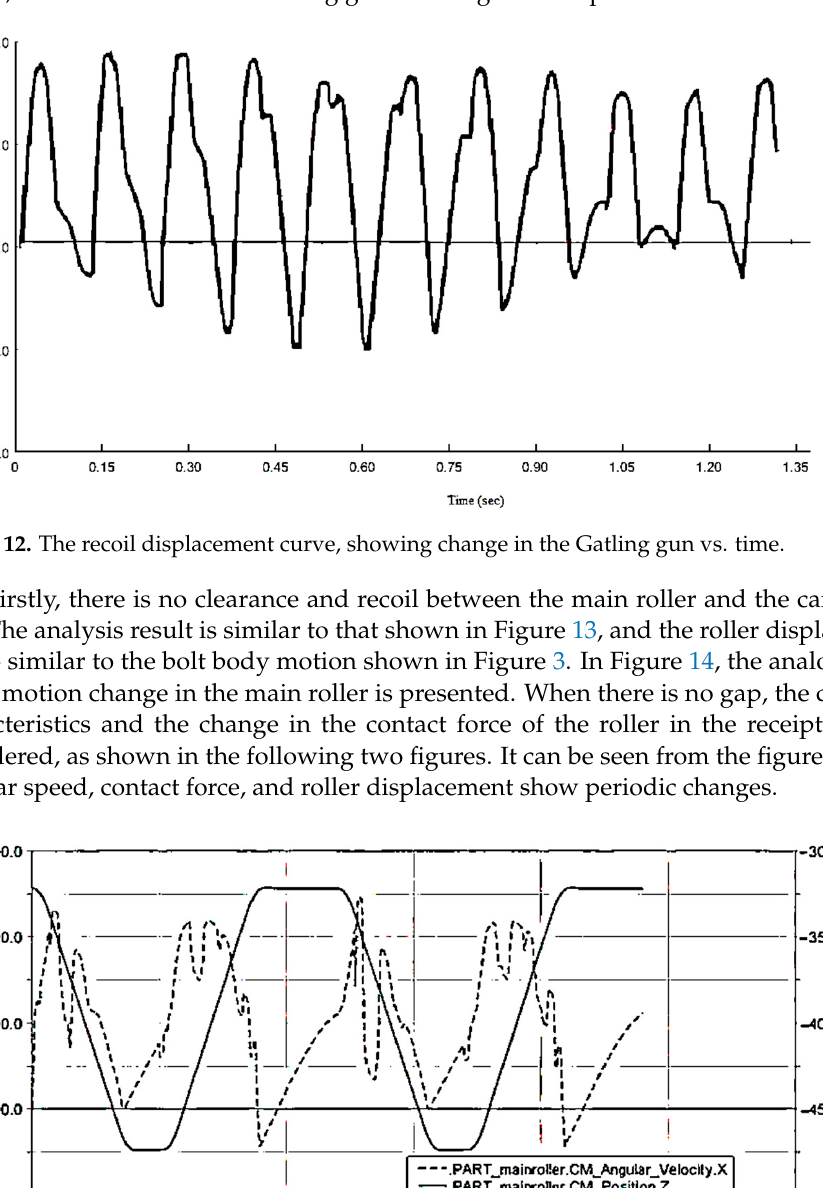
Figure 14. The motion change curve in the main roller with the consideration of gap and no recoil. The dynamic characteristics of the main roller of the gap secondary cam mechanism are shown in Figures 13 and 14: the red dashed line represents the angular speed of the main roller, the solid black line represents the position of the main roller, the blue dotted line represents the change in the contact force of the main roller and the rear end of the curve groove, and the black dotted line represents the contact force of the change in the front end of the main roller. It can be seen that, because of the existence of the gap, the main roller and the two ends occur. After the firing rate is stabilized, the automaton gradually tends towards the periodic movement. During an average cycle, the main roller meets the front end once, and the contact force of the main roller and the rear-end surface changes periodically. The main roller cannot meet the conditions required for pure rolling, so only translation motion can occur, and not rolling; the contact surface is a finite domain inside contact, and sliding friction occurs. Figure 15 illustrates the contact force variation of the front end and rear end of the cam slot curve with time t. The maximum value of the contact force exceeds 5000 N. The dotted line indicates the angular velocity of the main roller. The black line indicates the mass center of the main roller along the Z -axis between 475 mm and − 375 mm.